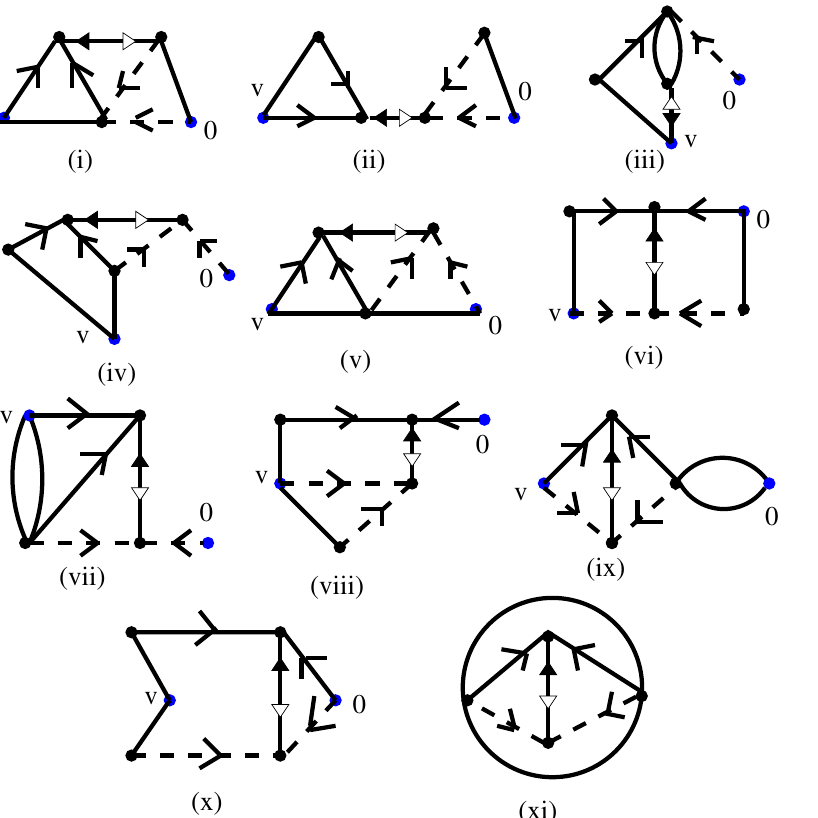
Figure 8 . The auxiliary graphs (i) π 3 A 1 ( v ) , (ii) π 3 A 2 ( v ) , (iii) π 2 A 3 ( v ) , (iv) π 3 A 4 ( v ) , (v) π 3 A 5 ( v ) , (vi) π 3 A 6 ( v ) , (vii) π 3 A 7 ( v ) , (viii) π 3 A 8 ( v ) , (ix) π 3 A 9 ( v ) , (x) π 3 A 10 ( v ) , (xi) π 3 A 11 ( v )